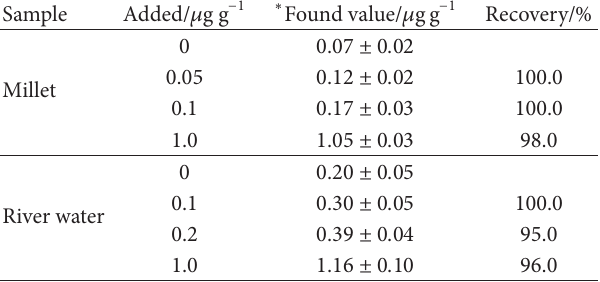
T 3: Determination of cobalt in water and millet samples